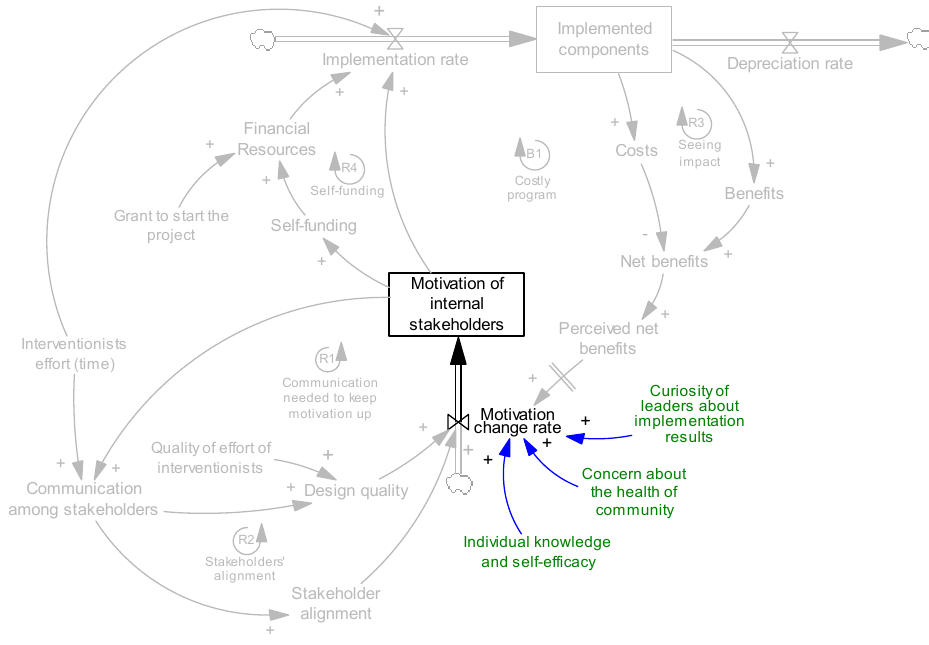
Figure 7. Examples of non-dynamic factors (green parameters) affecting